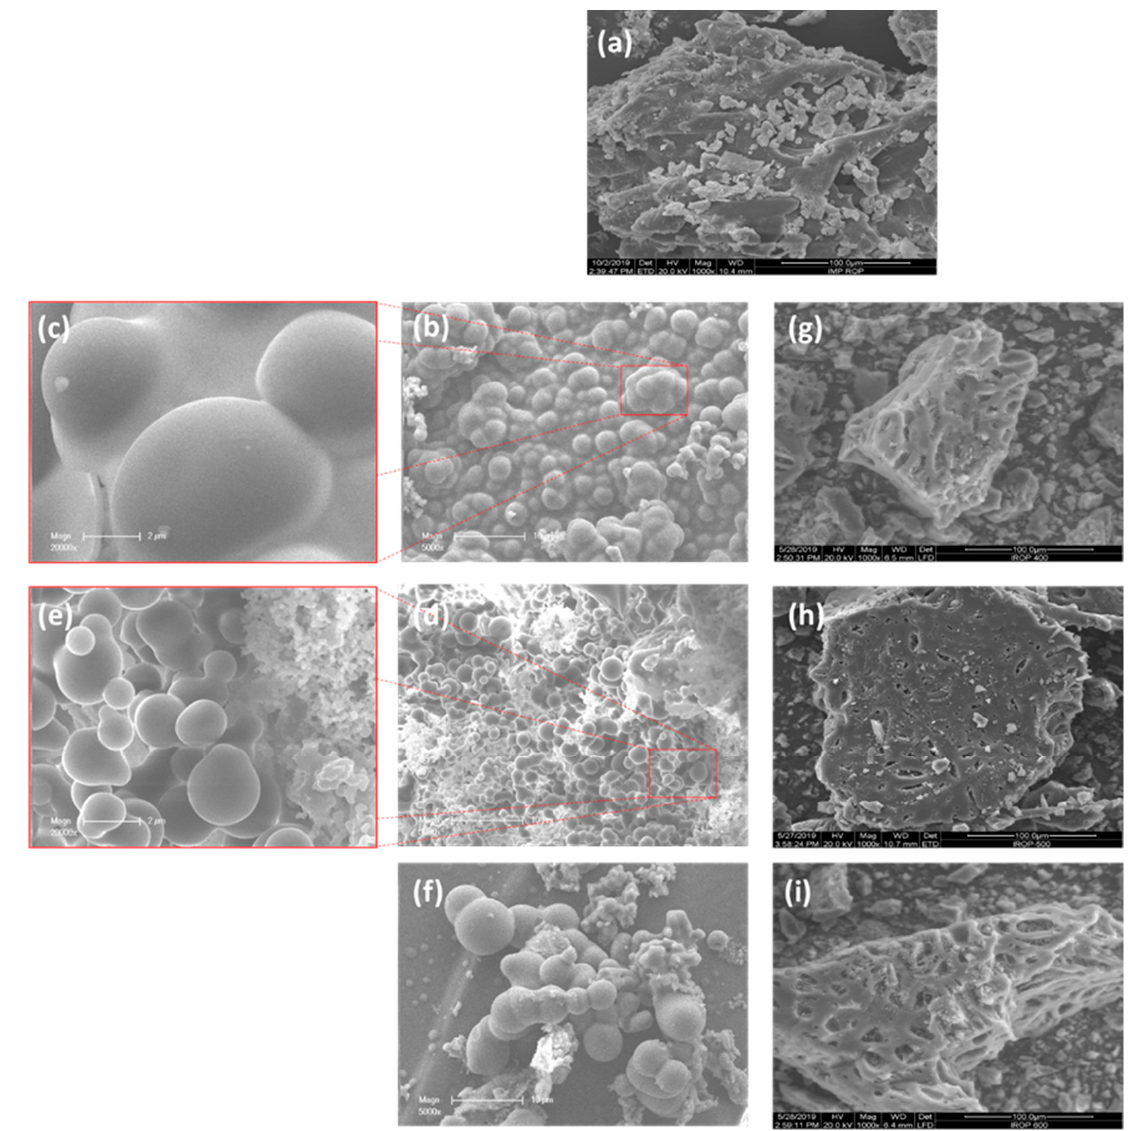
Figure 3. Scanning electron microscope images of ( a ) impregnated raw olive pomace and the produced ( b – f ) hydrochars and ( g – i ) biochars under different carbonization conditions .